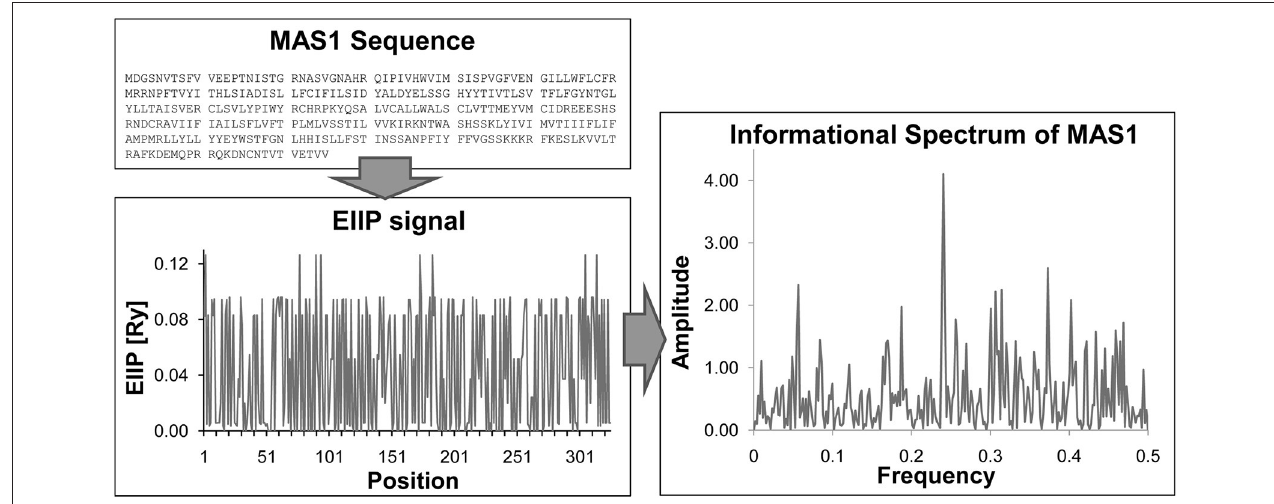
FIGURE 1 | Basic steps of ISM method. Sequence → Transformation of primary protein sequence into sequence of numbers, by assigning of EIIP to each amino acid → Numerical presentation → Discrete Fourier transformation → Informational spectrum